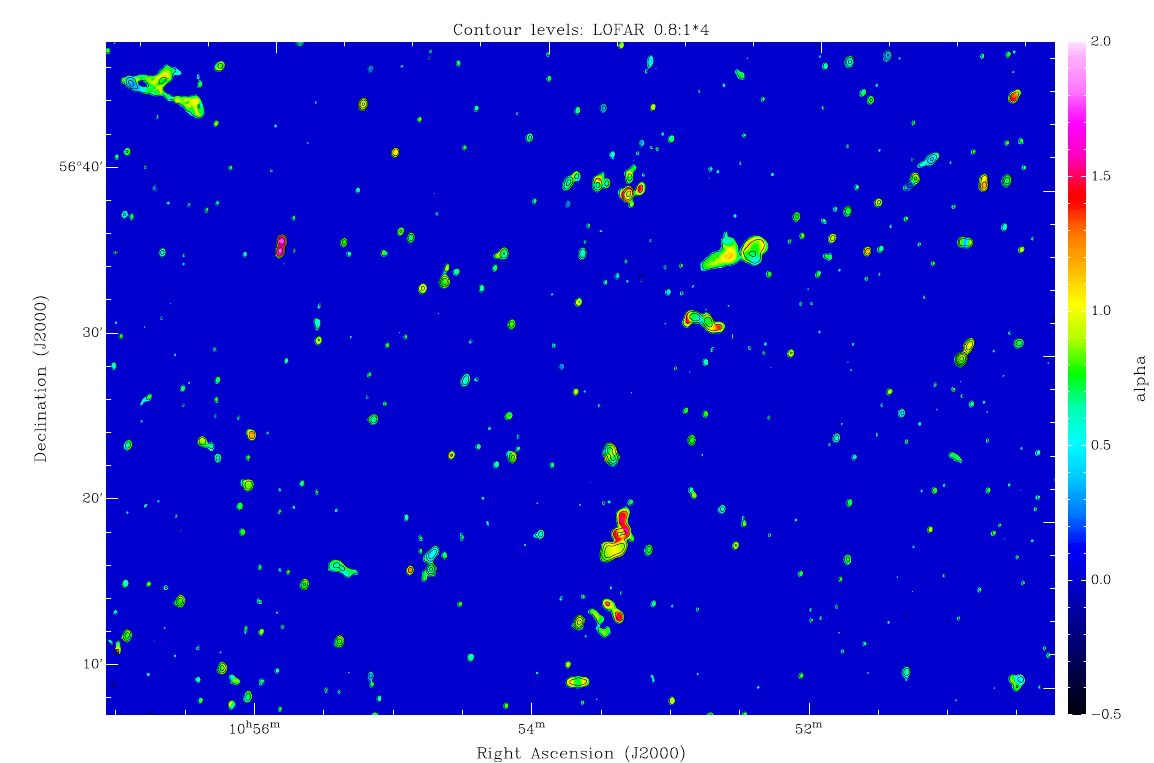
Figure 2. A relatively small region (about 40 arcmin 2 ) extracted from the 20 sq deg spectral index image of the Lock- man Hole area. Spectral indices are derived between 150 and 1400 MHz (LOFAR-Apertif) with a spatial resolution of 19 × 15 ArcSection. The LOFAR image has been convolved to this resolution. The contours (from 0.8 mJy beam − 1 to 1 Jy beam − 1 in steps of a factor 4) represent the LOFAR emission. The colour scale represents the spectral index values: red colours indicate steep spectrum regions, blue colours the regions with flat spectrum. Some of the spectral indices are lower limits, i.e., in regions undetected by Apertif the limits are derived assuming for the 1400 MHz flux an upper limit of 5- σ , where σ = 40 µ Jy. See text and Figure 3 for details. Sources undetected by LOFAR, but detected by Apertif (i.e., with strong inverted spectrum), are not considered in this